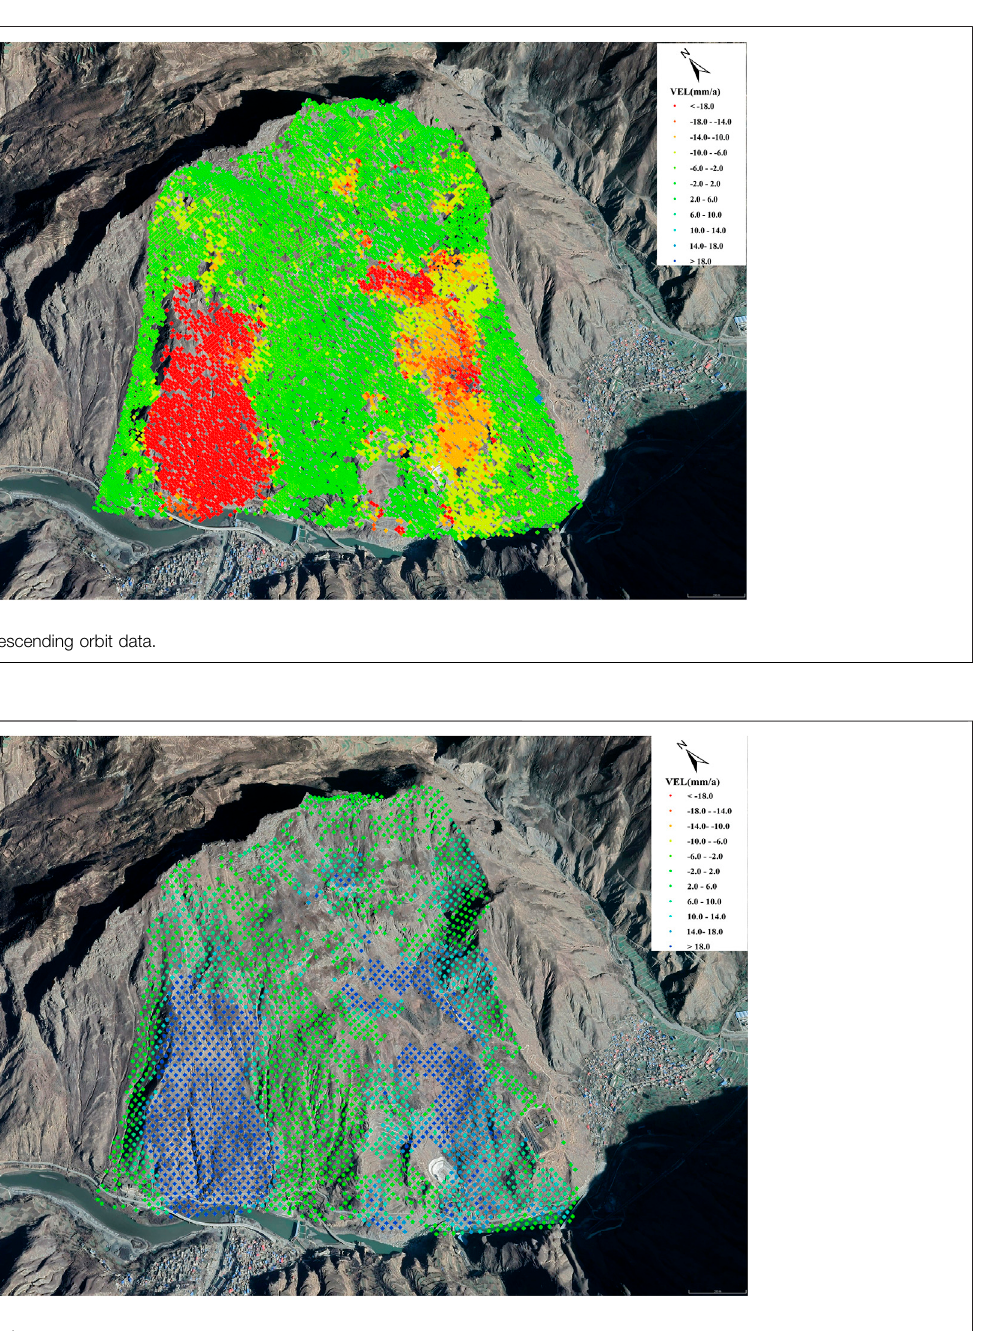
FIGURE 10 | The deformation along the